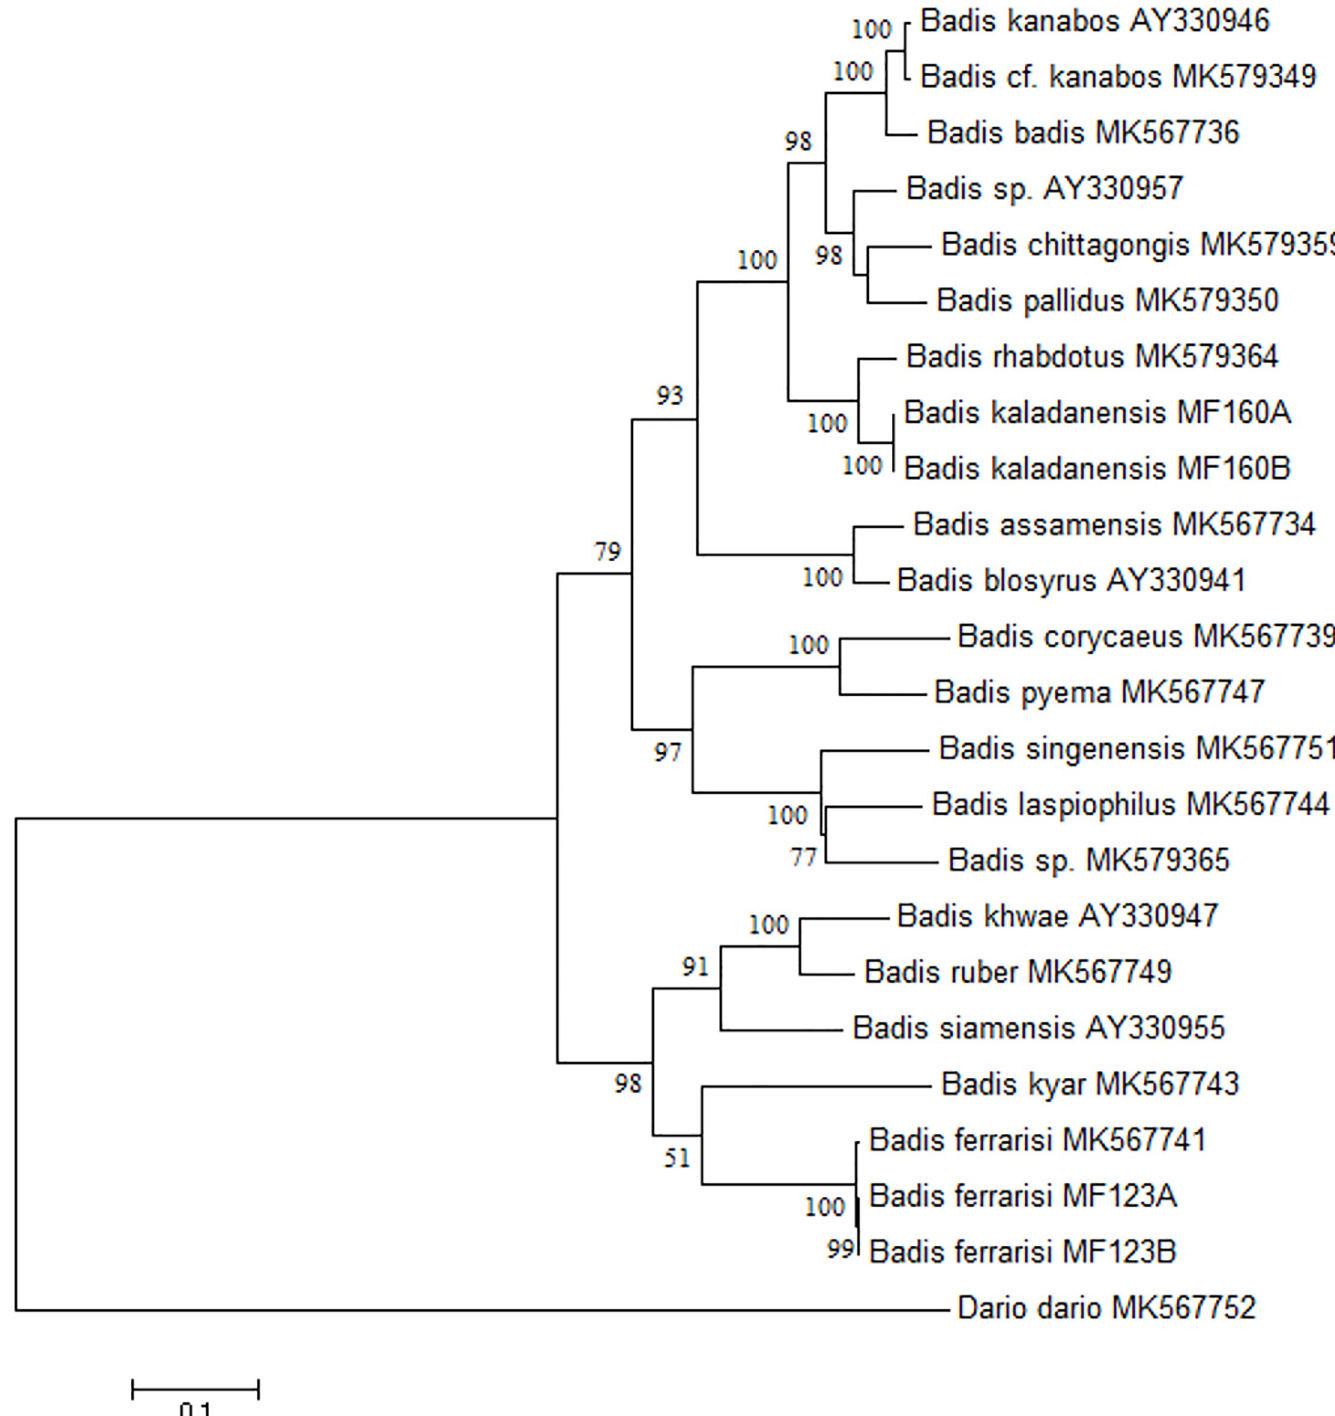
Fig 2. Maximum Likelihood (ML) tree of cytb dataset of 36 sequences using HKY+G+I nucleotide substitution model with 1000 bootstraps.